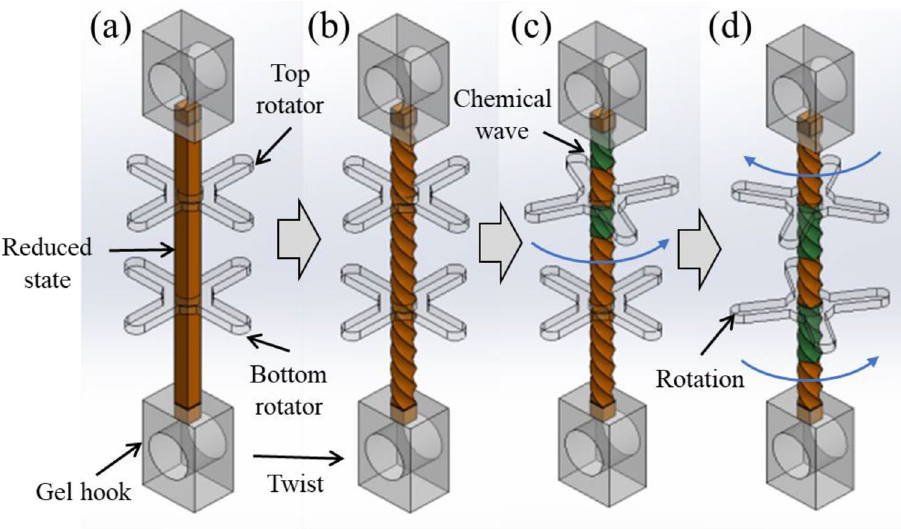
Figure 4. ( a ) Assembly of the BZ gel, top PDMS rotator, bottom rotator, and gel hooks. ( b ) Pre-twist of the BZ gel. ( c ) Counterclockwise rotation of the top rotator as the chemical wave propagates. ( d ) Clockwise rotation of the top rotator and counterclockwise rotation of the bottom rotator. ( a – d ) are created by Adobe Illustrator (CC2015) https:// www. adobe. com/ jp/ produ cts/ illus trator. html).